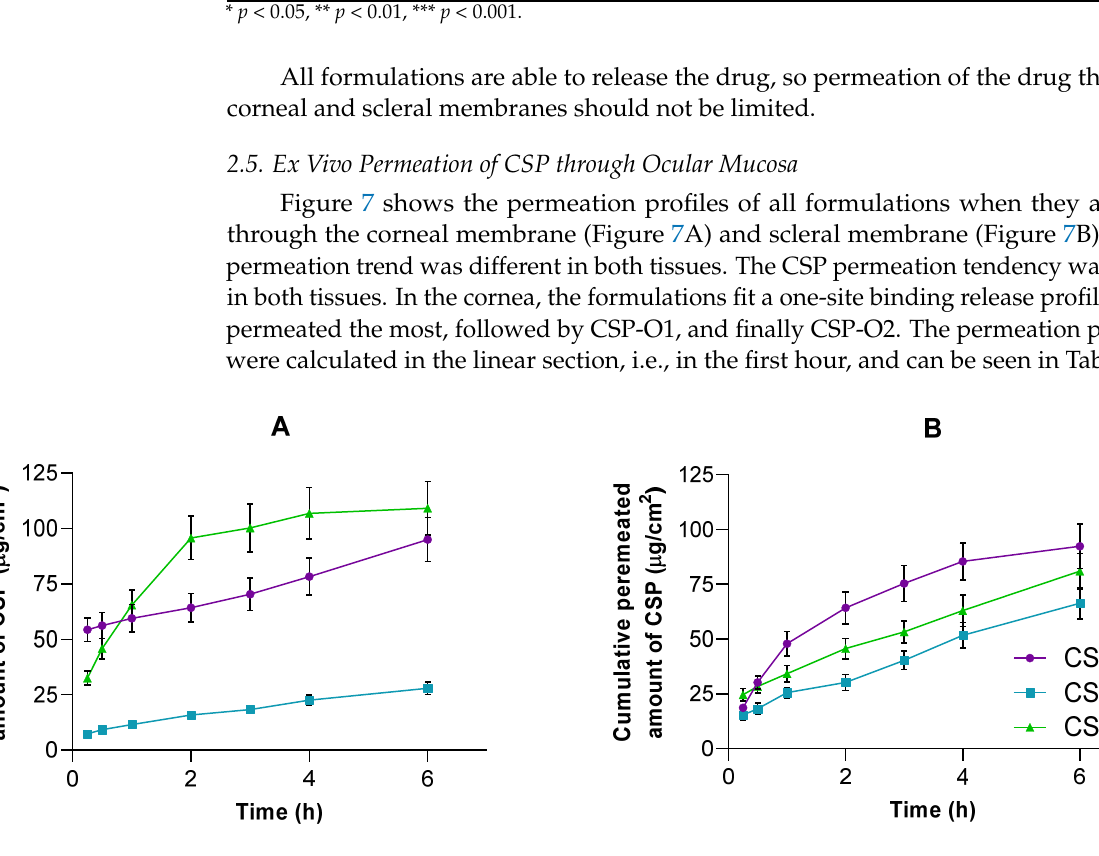
Figure 7. Cumulative amount of CSP permeated ( µ g) through ( A ) the corneal membrane and ( B ) the scleral membrane upon application of CSP formulations. Each value represents the mean ± SD ( n =6).